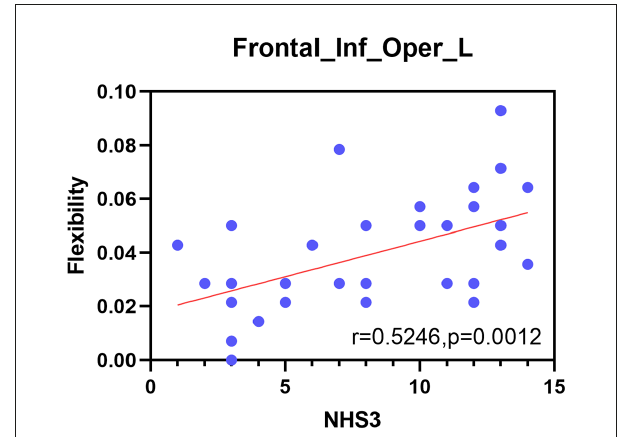
FIGURE7 Correlation between the NHS3 scores and the opercular part of inferior frontal